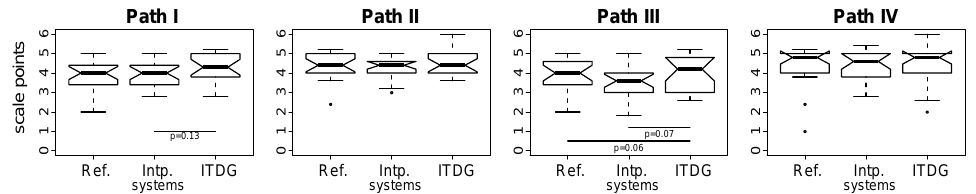
Figure 15. Boxplots for Overall Impression (OI) rated on the scale shown in Figure 12; Differences between distributions with p < 0.2 using a Wilcox-test are indicated; scale labels: 0 = extremely bad, 1 = bad, 2 = poor, 3 = fair, 4 = good, 5 = excellent, 6 = ideal (data from the work in [43]). The stability of the perceived position of the auditory event is shown in Figure 16.